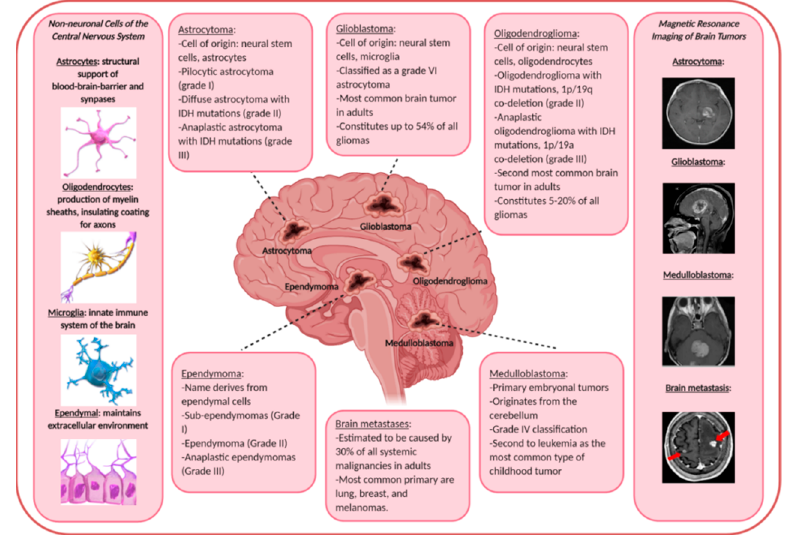
Figure 1. Summary of the different malignant brain tumors that are discussed in this review, their name-derived cell of origin, and real-life images taken from patients. Classifications are adapted from the World Health Organization [51]. Drawings of cells and patient tumor magnetic resonance imaging images are taken from the public domain